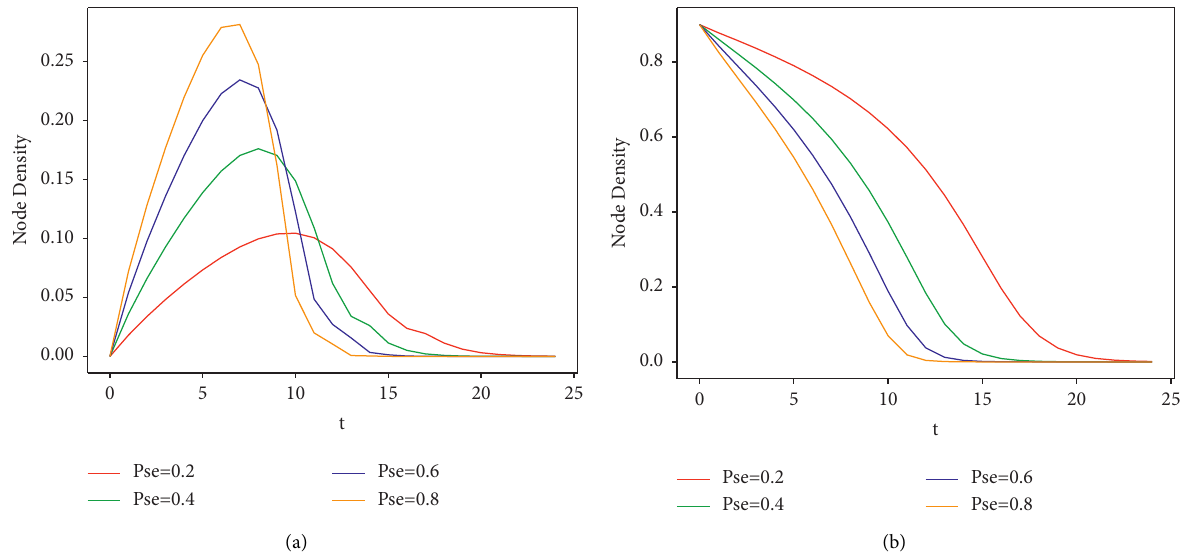
Figure 5: The influence of different p S and node E . (a) The evolution trend of node E , (b) The evolution se on the evolution trend of node trend of node S .